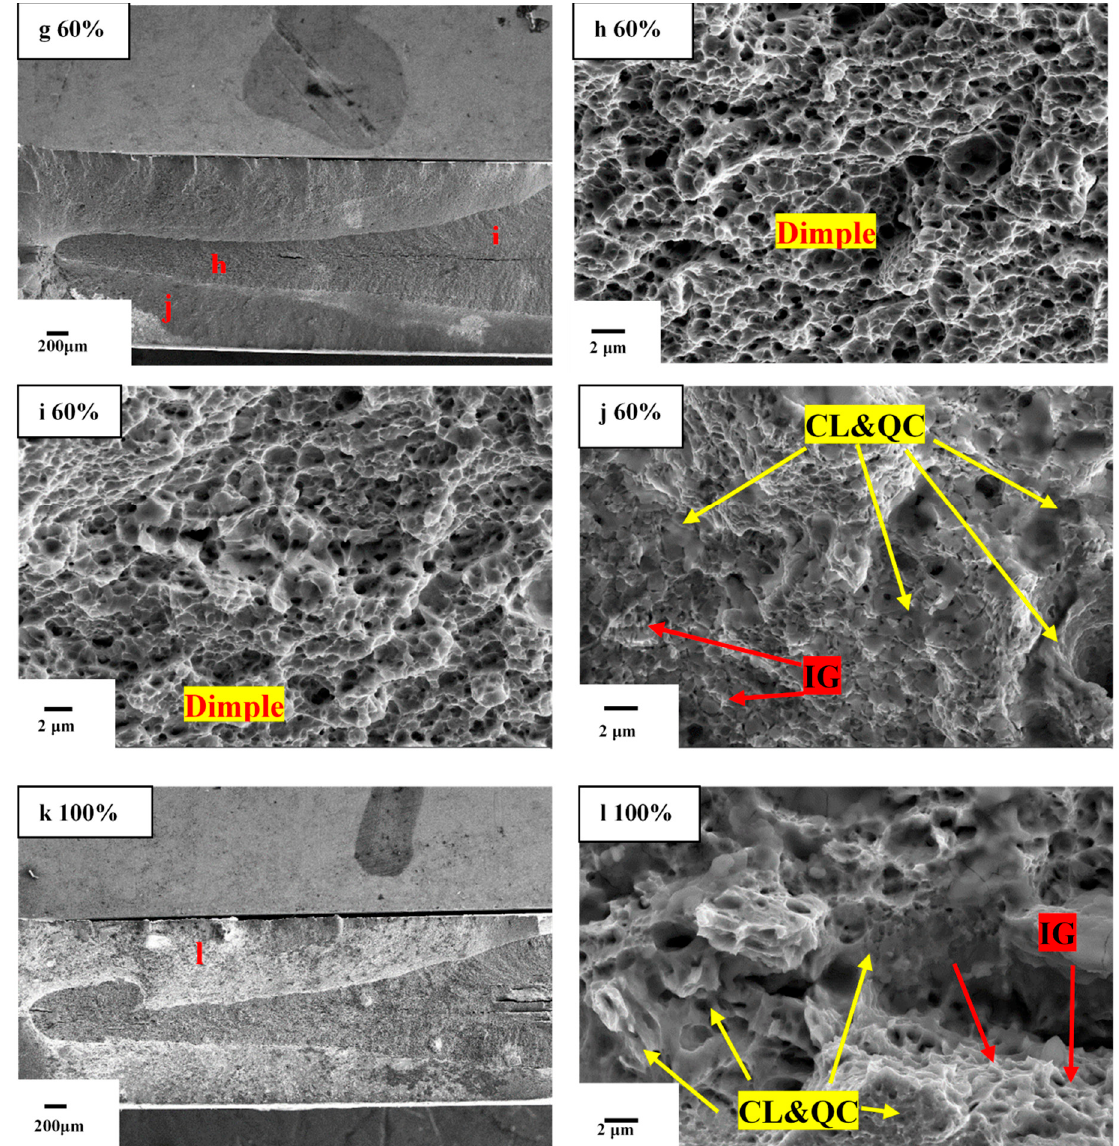
Figure 6. Fracture surface of M7B after SSRTT under di ff erent relative humidity (RH) conditions with di ff erent strain rates: ( a , b ) in air at 10 − 4 s − 1 ; ( c , d ) in 60% RH at 10 − 5 s − 1 ; ( e , f ) in 100% RH at 10 − 5 s − 1 ; ( g – j ) in 60% RH at 10 − 6 s − 1 ; ( k , l ) in 100% RH at 10 − 6 s − 1 . The area of brittle zone tends to increase with the increase of RH, which accelerated the entry of hydrogen into the sample by hydrogen adsorption and absorption. The detailed process is shown in Figure 7a the reactions of H 2 + M → H2M, H2M + M → 2HadM, HadM → MHab, MH ab → M + H, where H ad / H ab mean adsorbed / absorbed